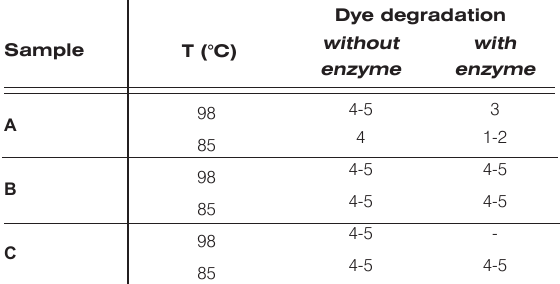
Dye degradation